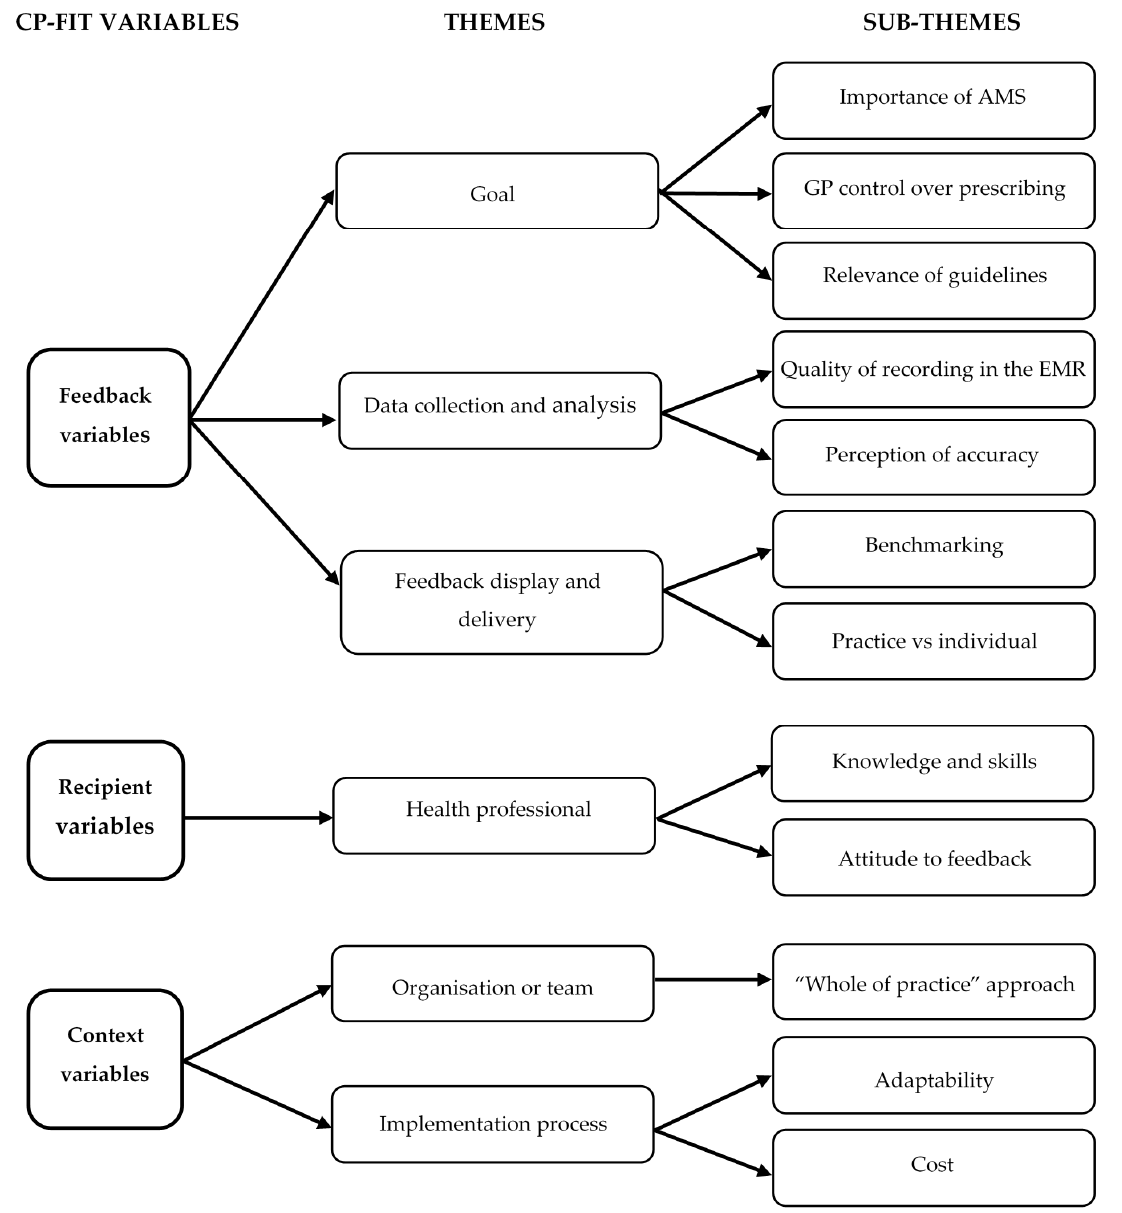
Figure 1. Clinical performance feedback intervention theory (CP-FIT) variables with corresponding themes and sub-themes. AMS = antimicrobial stewardship; EMR = electronic medical record.